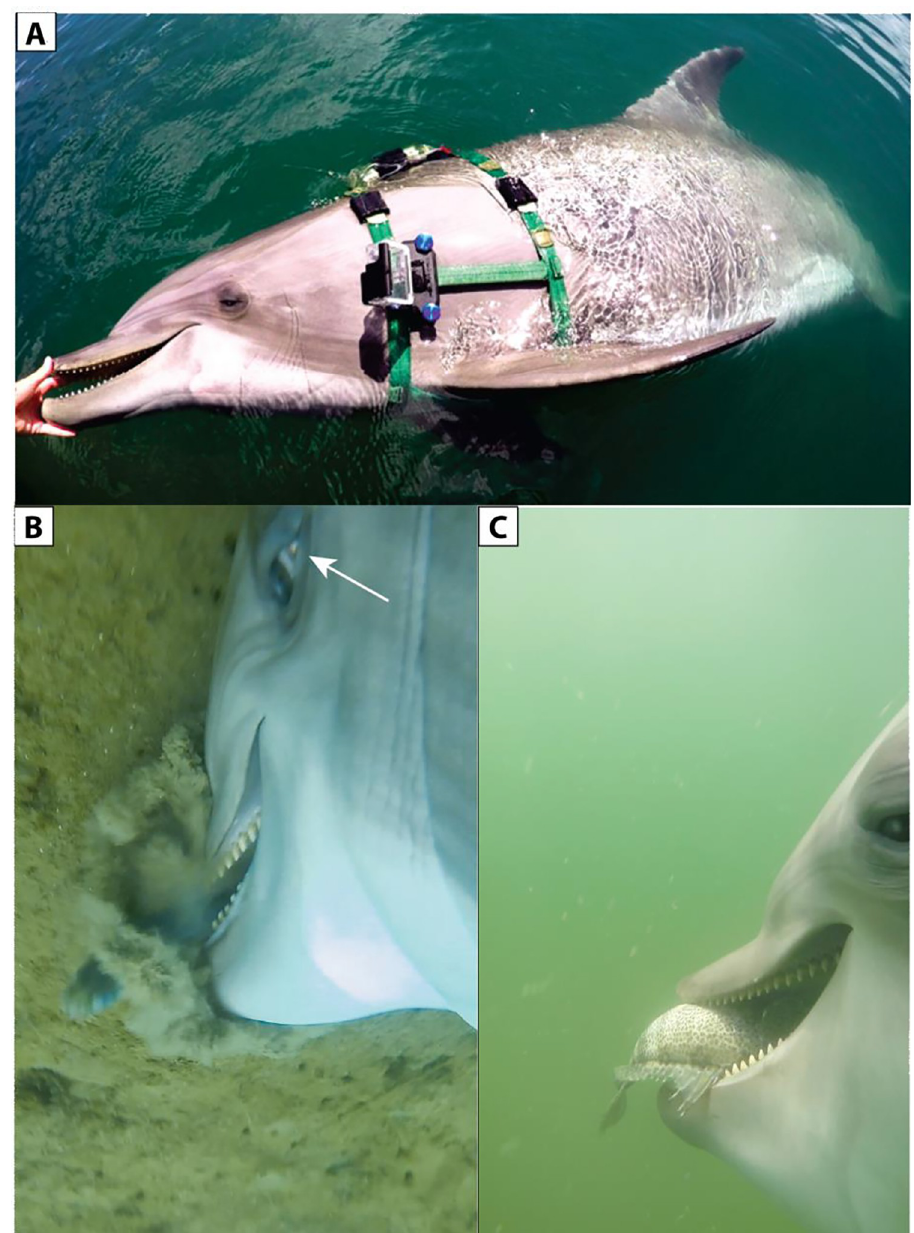
Fig 1. A. Dolphin S with camera attached to the left side of her harness. B. Dolphin S drills into the sea floor to seize a fish. Notice the white of the eye or sclera (arrow) shows the eye rotated toward the fish. C. Dolphin S brings out the fish with lips flaring in the posterior half of the gape area to show the upper tooth row and gular area